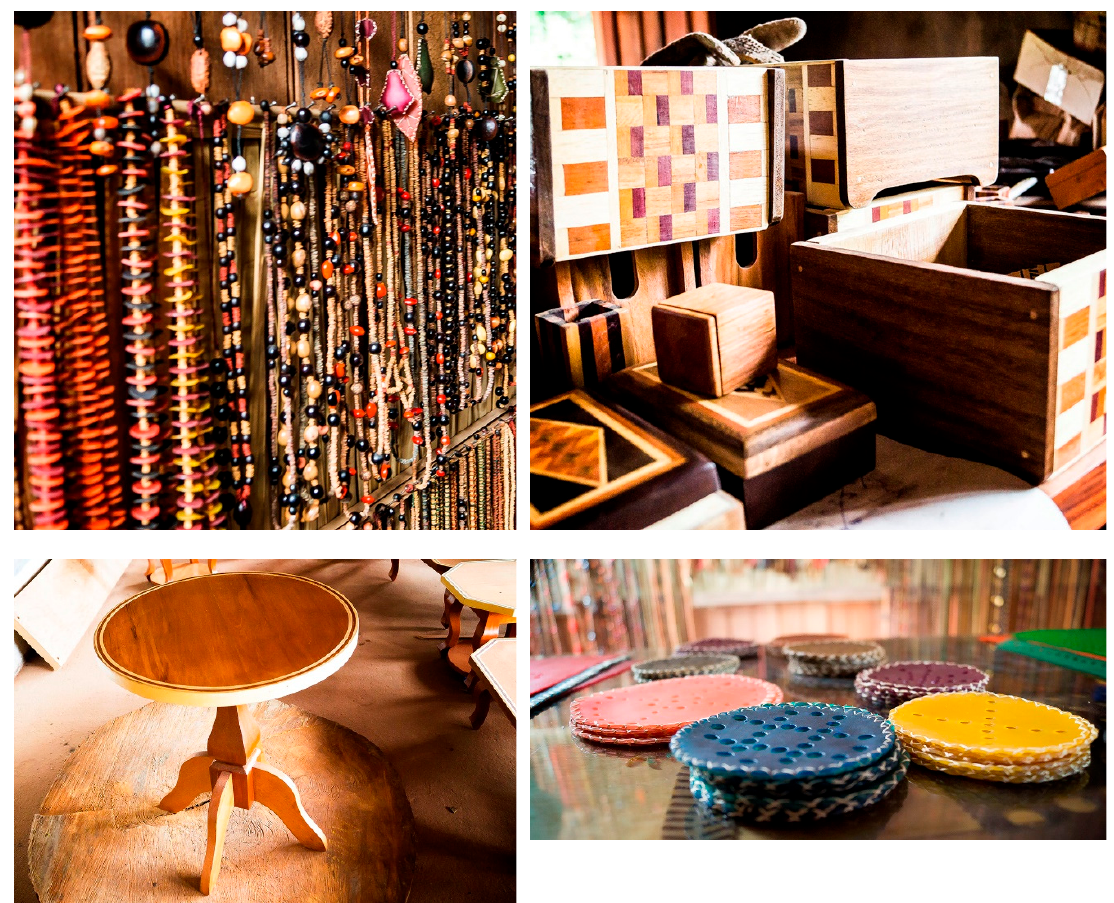
Figure 3. Products available at the store run by the cooperative in Santarém, the main municipality in western Pará state (Photos from Coomflona).